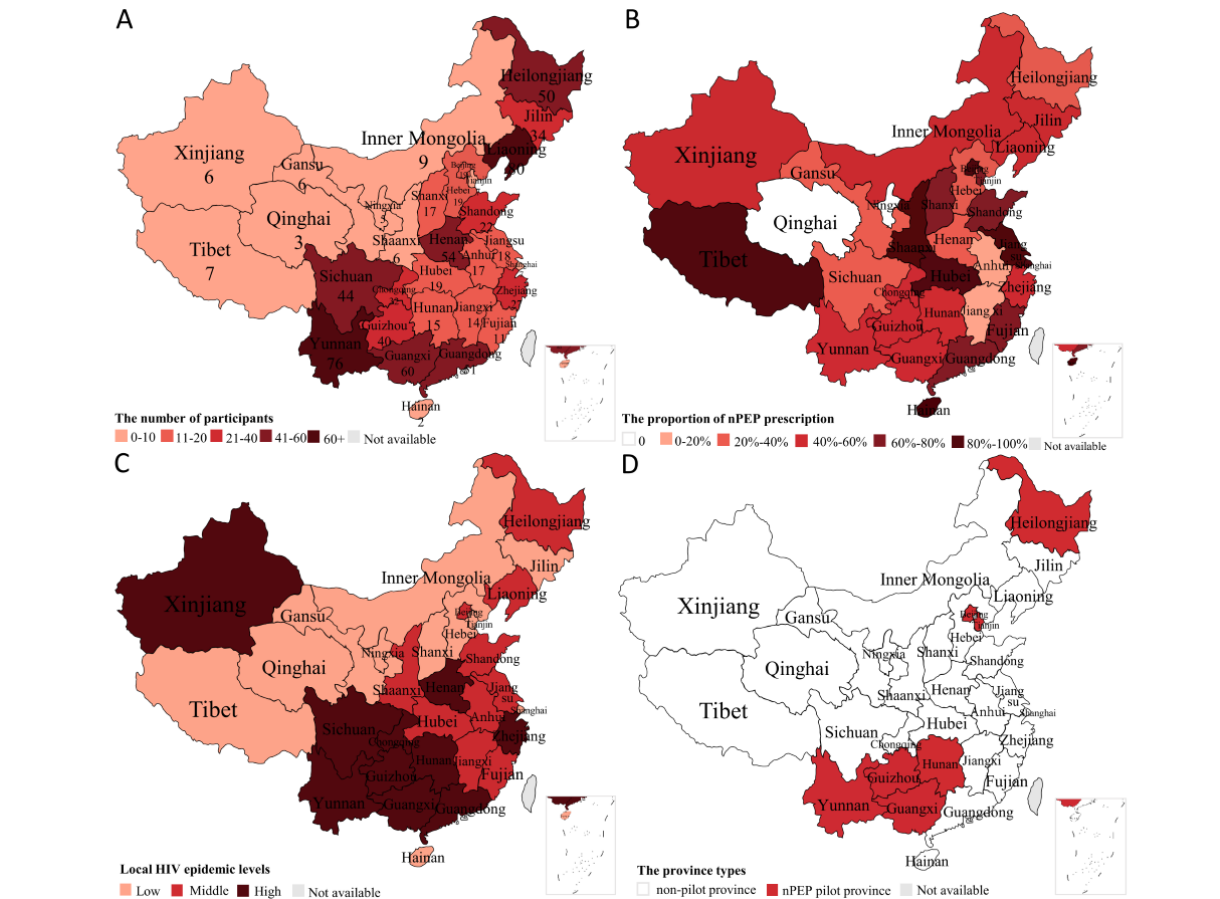
Figure 1. Distribution of participants (A), proportion of nonoccupational postexposure prophylaxis (nPEP) prescriptions (B), HIV epidemic level (C), and nPEP pilot versus nonpilot provinces of 31 total in China